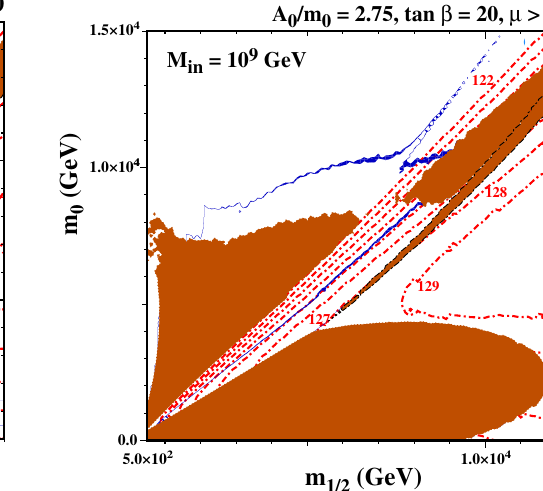
We show in Fig. 7 a comparison of relevant masses, plotted as functions of m 1 / 2 , in the CMSSM and a sub-GUT model with M in = 10 9 GeV, both with A 0 = 2 . 75 m 0 , tan β = 20, and μ > 0. The LSP mass lines are black, those for the ˜ t 1 are red, and those for the ˜ t 2 are purple. The dashed lines are for the masses in the CMSSM and the solid lines are for the sub- GUT model. In the sub-GUT case, we only plot the portion of the strip which is in between the stop and stau LSP regions. depend mostly on m 1 / 2 , their masses along Since m χ and m ˜ t 1 the other portion of the strip just overlap the existing